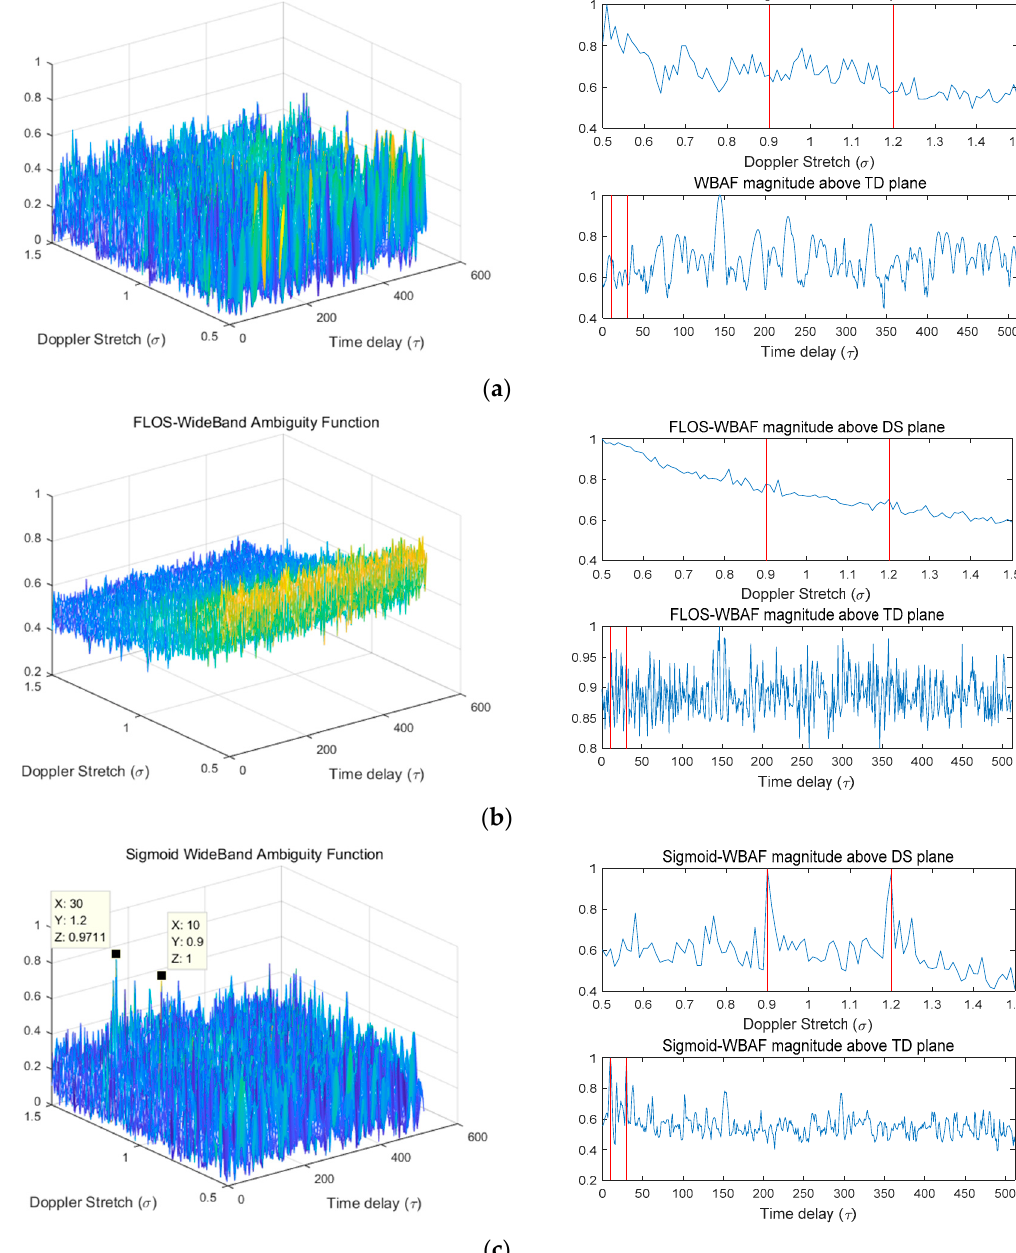
Figure 5. The normalized spectra of WBAF, FLOS-WBAF, and Sigmoid-WBAF for impulsive noise with GSNR = − 2 dB and α = 1.2. ( a ) The 3D plot of WBAF and its DS and TD section planes; ( b ) the 3D plot of FLOS-WBAF with p = 1.1 and its DS and TD section planes; ( c ) the 3D plot of Sigmoid-WBAF and its DS and TD section planes.